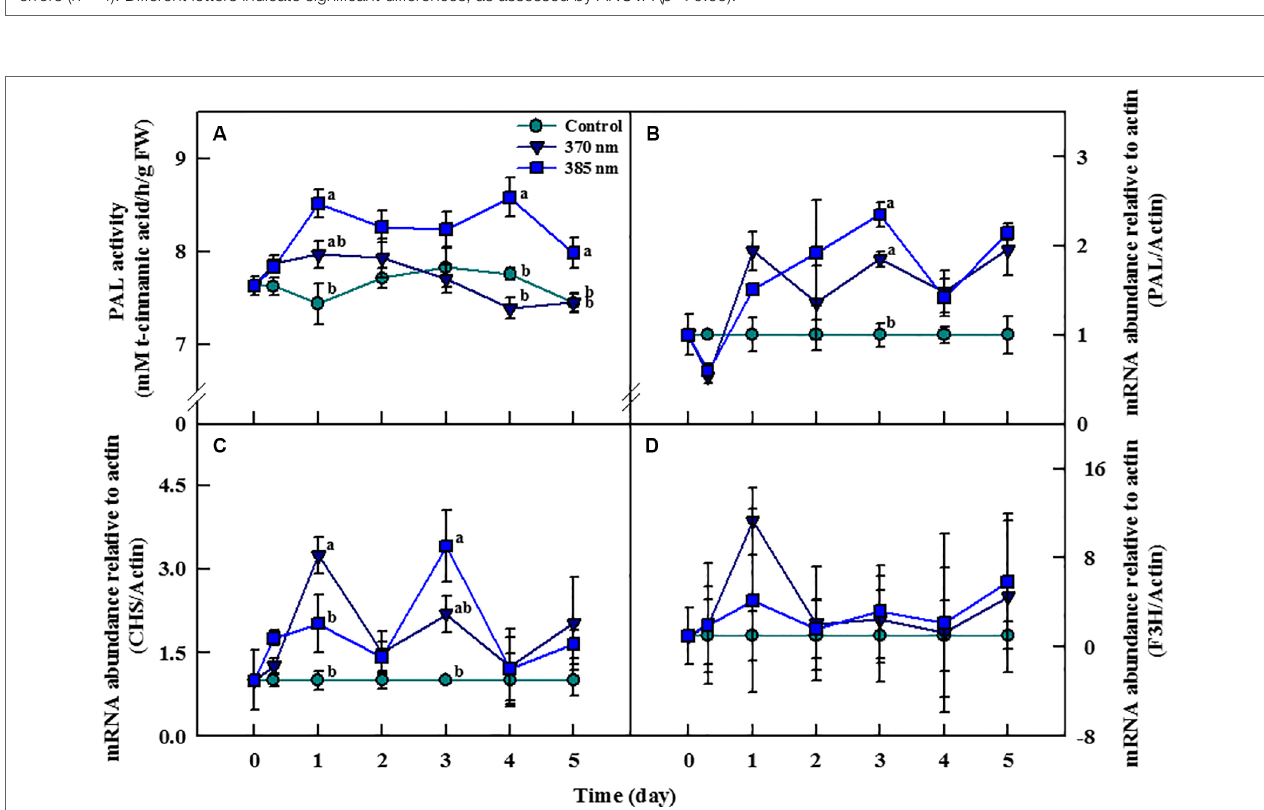
FIGURE 6 | Phenylalanine ammonia-lyase (PAL) activity (A) and transcript levels of PAL (B) , chalcone synthase (CHS) (C) , and flavonoid 3-hydroxylase (F3H) genes (D) of kale subjected to two types of UV-A LED lights for 5 days. Gene expression levels were normalized to that of actin gene, a housekeeping gene. The vertical bars indicate standard errors (n = 4). Different letters indicate significant differences, as assessed by ANOVA ( p <